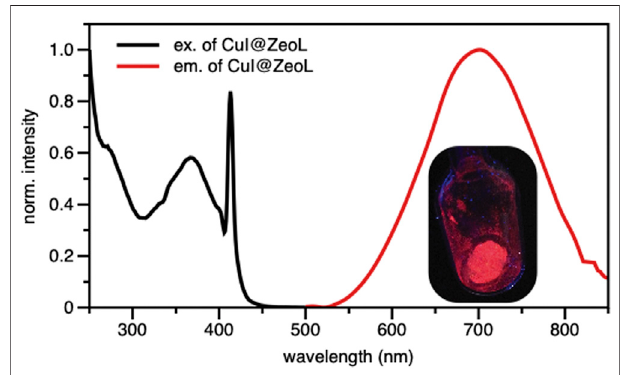
FIGURE 1 | Excitation ( λ em = 700 nm) and Emission ( λ exc = 414 nm) spectra of CuI@ZeoL in solid-state condition; inset is the photograph of CuI@ ZeoL inside the glass tube. The peak at 410 nm is an artifact.